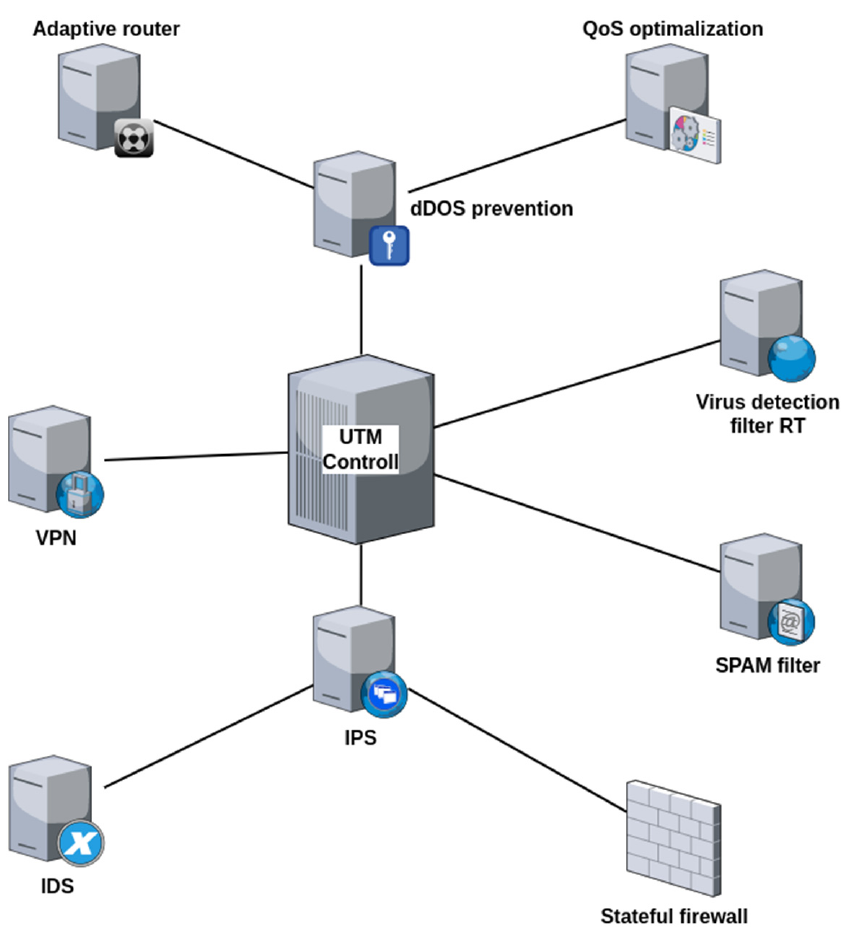
Figure 10. Components included in the UTM firewall.